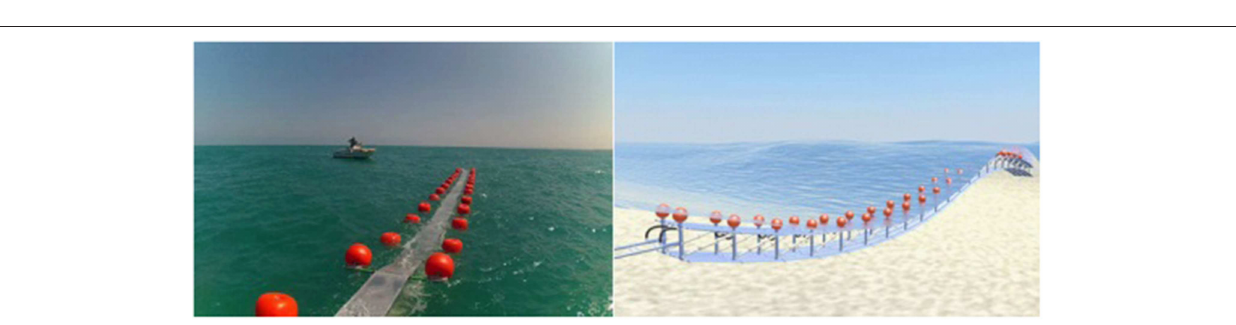
FIGURE 5 | Small scale prototype (Left) and CFD simulations of the OWC (Right) .